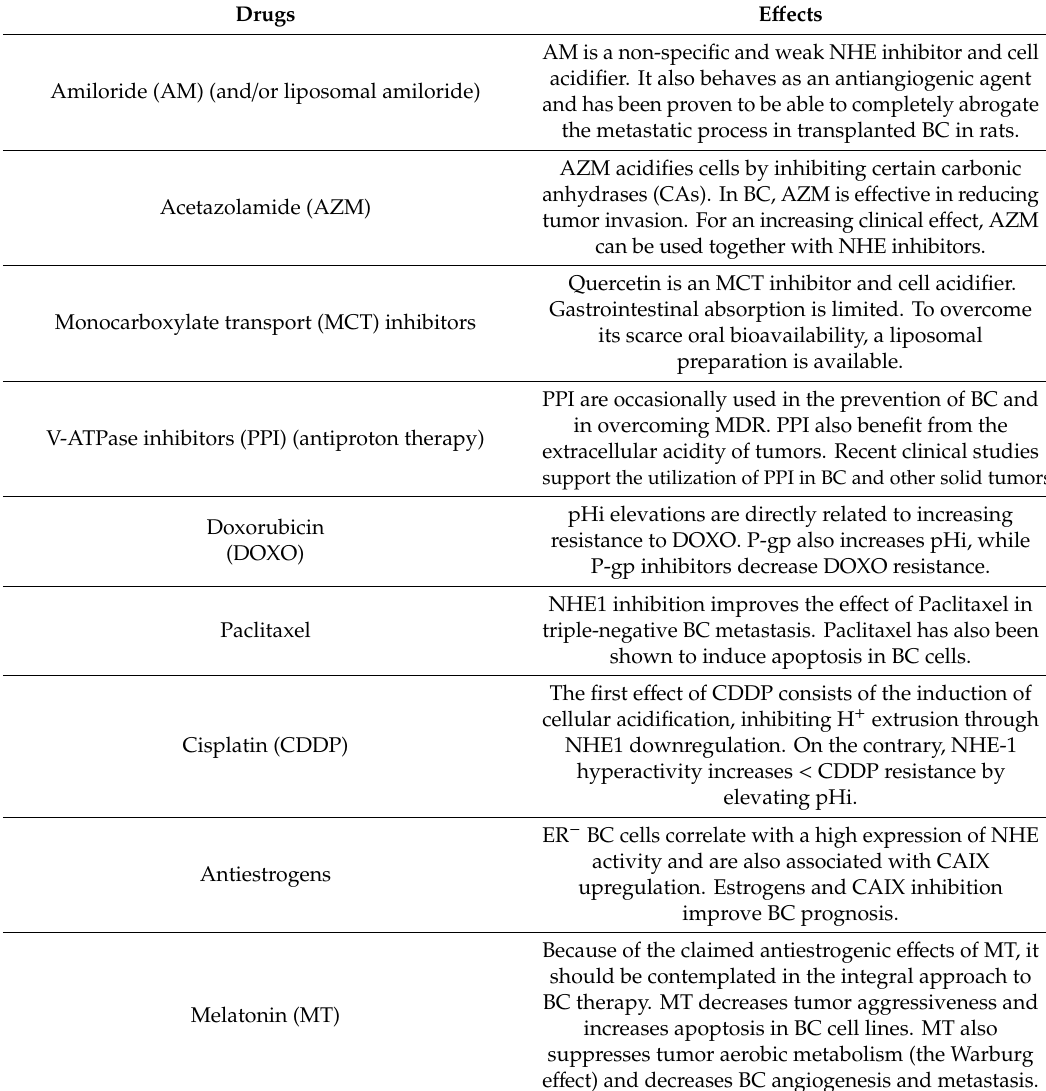
Table 1. pH and / or H + -related options in the treatment of breast cancer. BC: breast cancer;